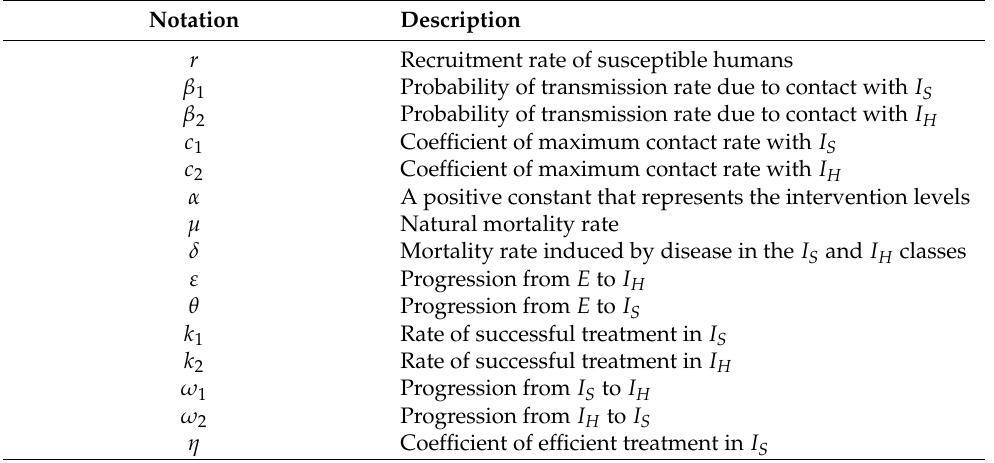
Figure 1. Diagram of Population Interations. Table 1. Parameters